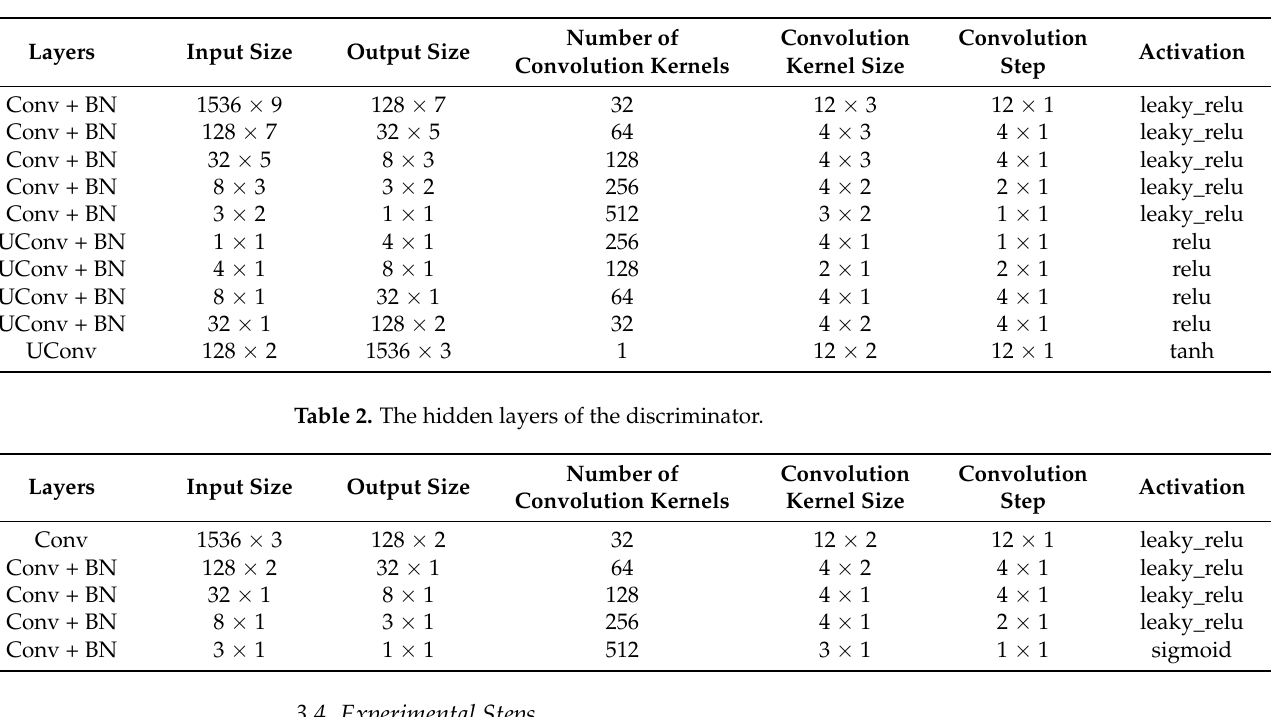
Table 1. The hidden layers of the generator.